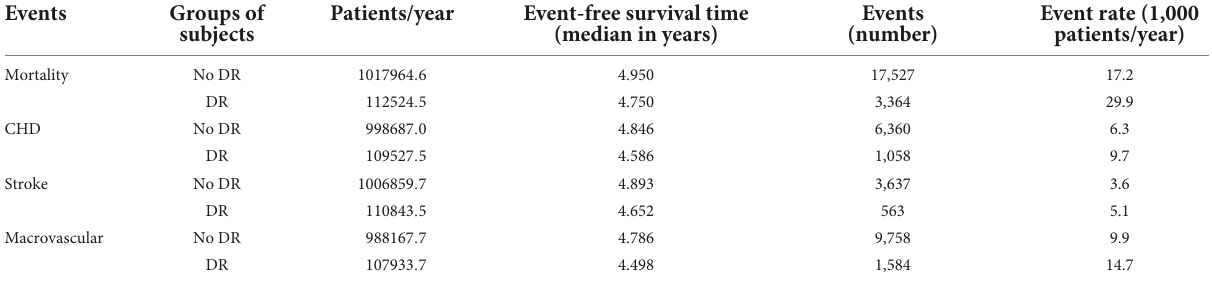
TABLE 2 The overall incidence for the study events between both